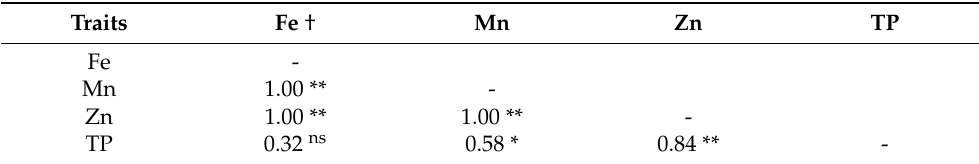
Table 7. Genetic correlations among nutritional composition traits evaluated in 15 cowpea genotypes across test environments. Traits Fe † Mn Zn TP Fe - Mn 1.00 ** - Zn 1.00 ** 1.00 ** - TP 0.32 ns 0.58 * 0.84 ** - † Fe, iron; Mn, manganese; Zn, zinc; TP, total protein; *, significant at p ≤ 0.05; **, significant at p ≤ 0.01. ns ,